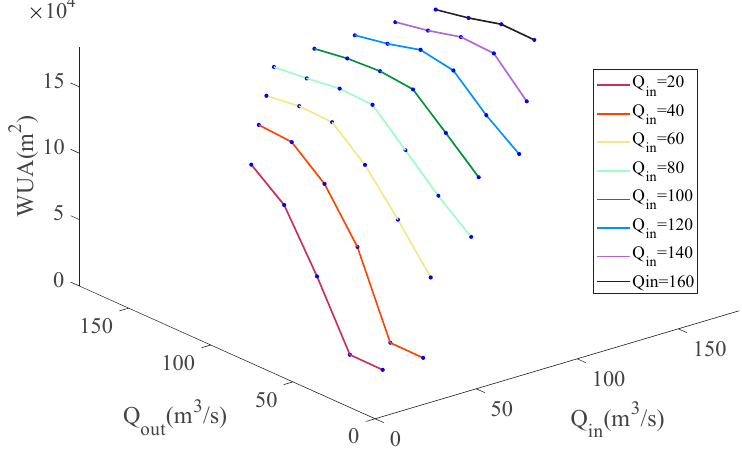
Figure 11. Weighted usable area (WUA) curves for C. idella in the study area. Table 3. Hydraulic habitat suitability (HHS) under different inflow and outflow scenarios.